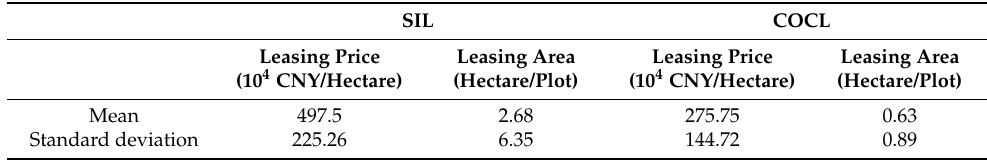
Table 4. Comparison between SIL and